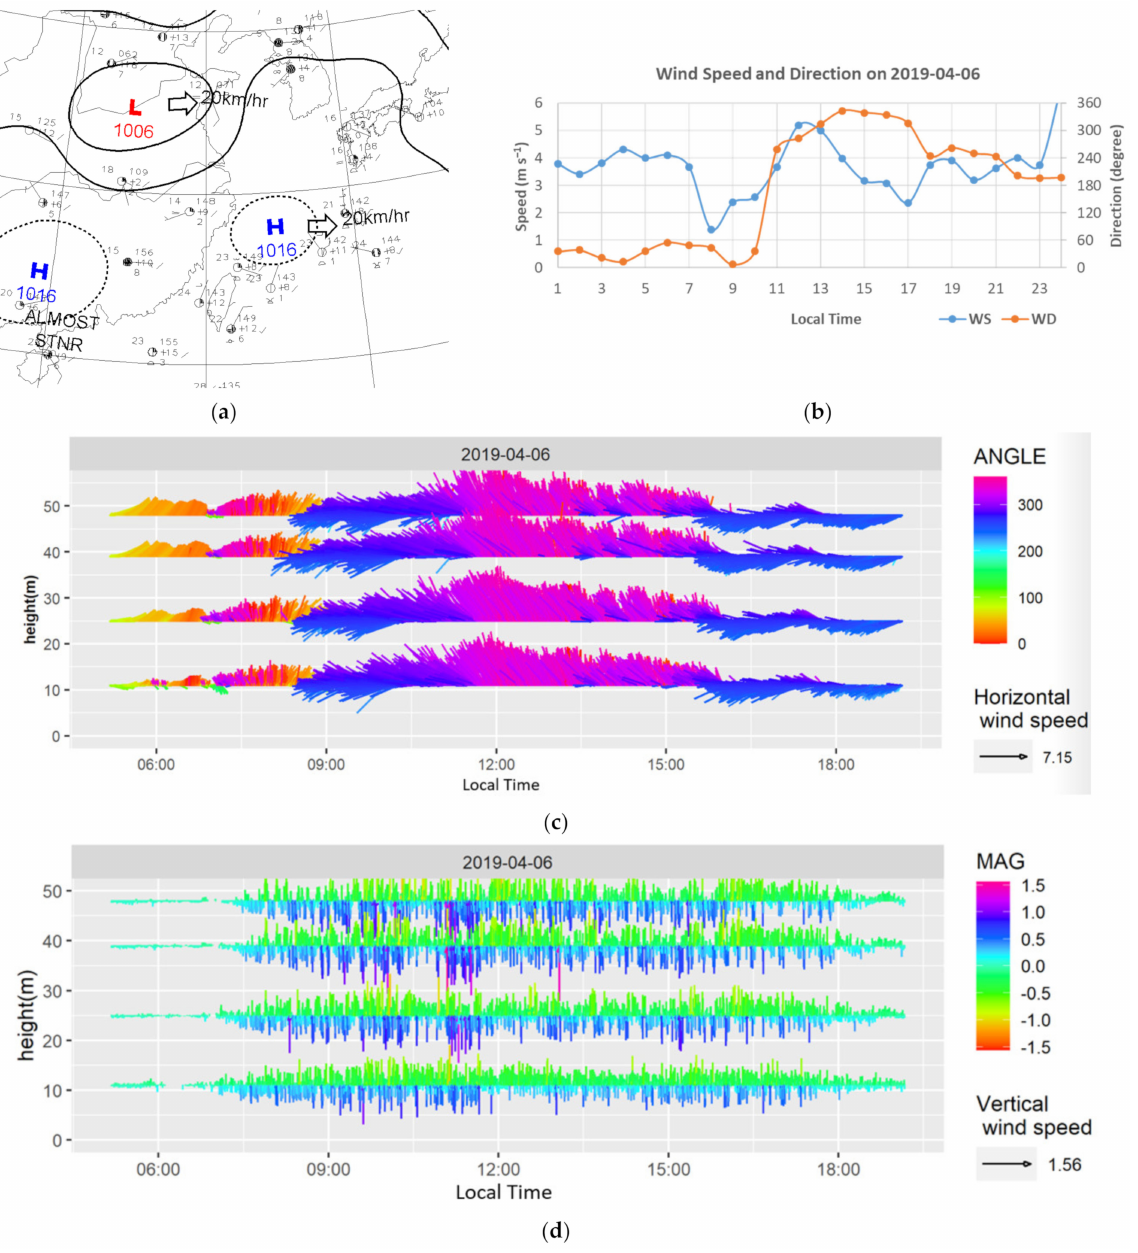
Figure 14. ( a ) The surface weather chart at 00:00 UTC on 6 April 2019. ( b ) Wind Speed (WS) and Direction (WD) at 100 m height on 6 April 2019 (pure sea breeze). ( c ) Horizontal wind speed component of 11 m, 25 m, 39 m and 48 m on 6 April 2019 (pure sea breeze). ( d ) Vertical wind speed component of 11 m, 25 m, 39 m and 48 m on 6 April 2019 (pure sea